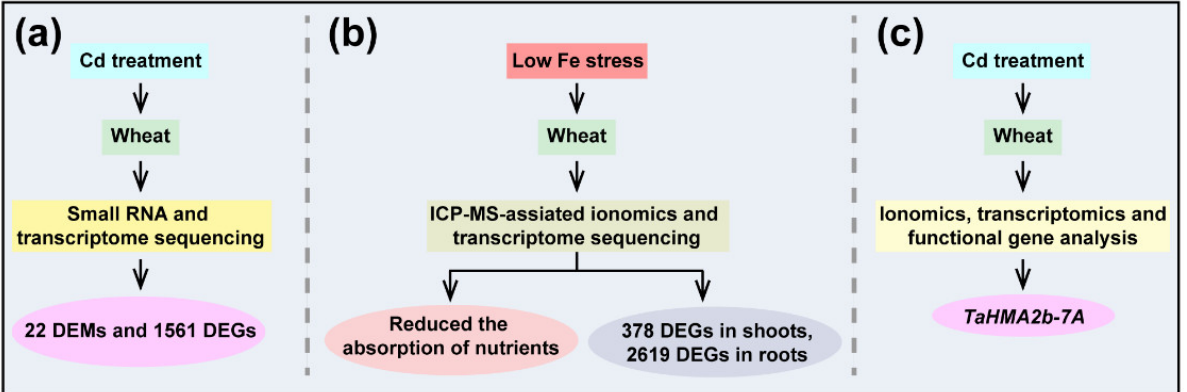
Figure 2. Combined multi-omics to study wheat under heavy metal stress. ( a ) In all, 22 differentially expressed microRNAs (DEMs) and 1561 differentially expressed genes (DEGs) were identified in a low-Cd-accumulating wheat cultivar through small RNA and transcriptome sequencing. ( b ) Low-Fe stress significantly reduced the absorption of nutrients through ICP-MS-assisted ionomic analysis; 378 and 2619 DEGs were found in the shoots and roots of wheat under low-Fe conditions. ( c ) TaHMA2b-7A , an important Cd exporter regulating long-distance Cd translocation, was identified in wheat through combining ionomics, transcriptomics and functional gene analysis.